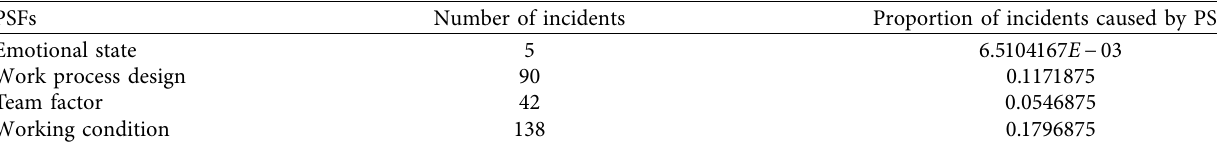
Table 4: Input data for PSFs with numerical values in the HEISM-DA.